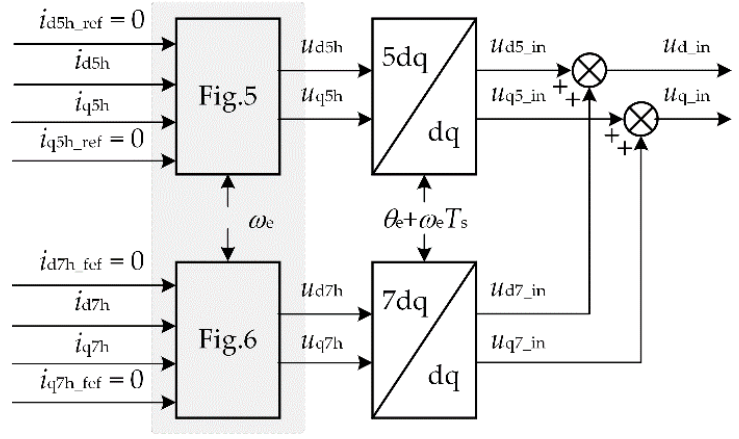
Figure 7. The block diagram of current harmonic controller based on IDPC.